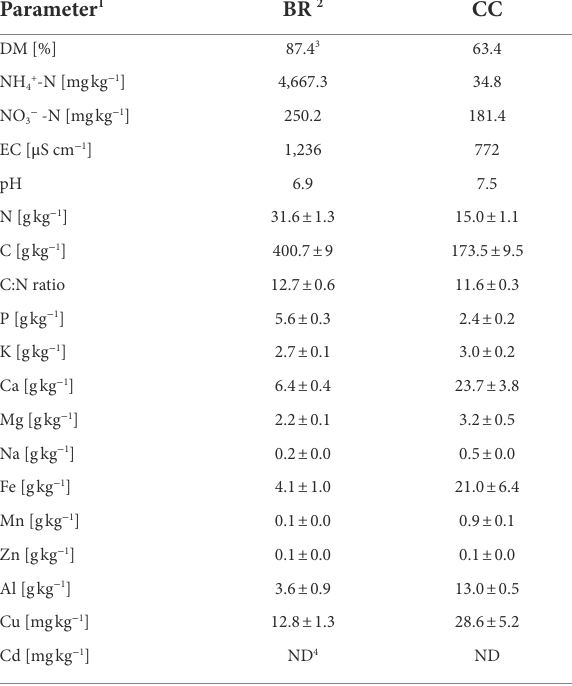
TABLE 2 Physicochemical characteristics of the applied